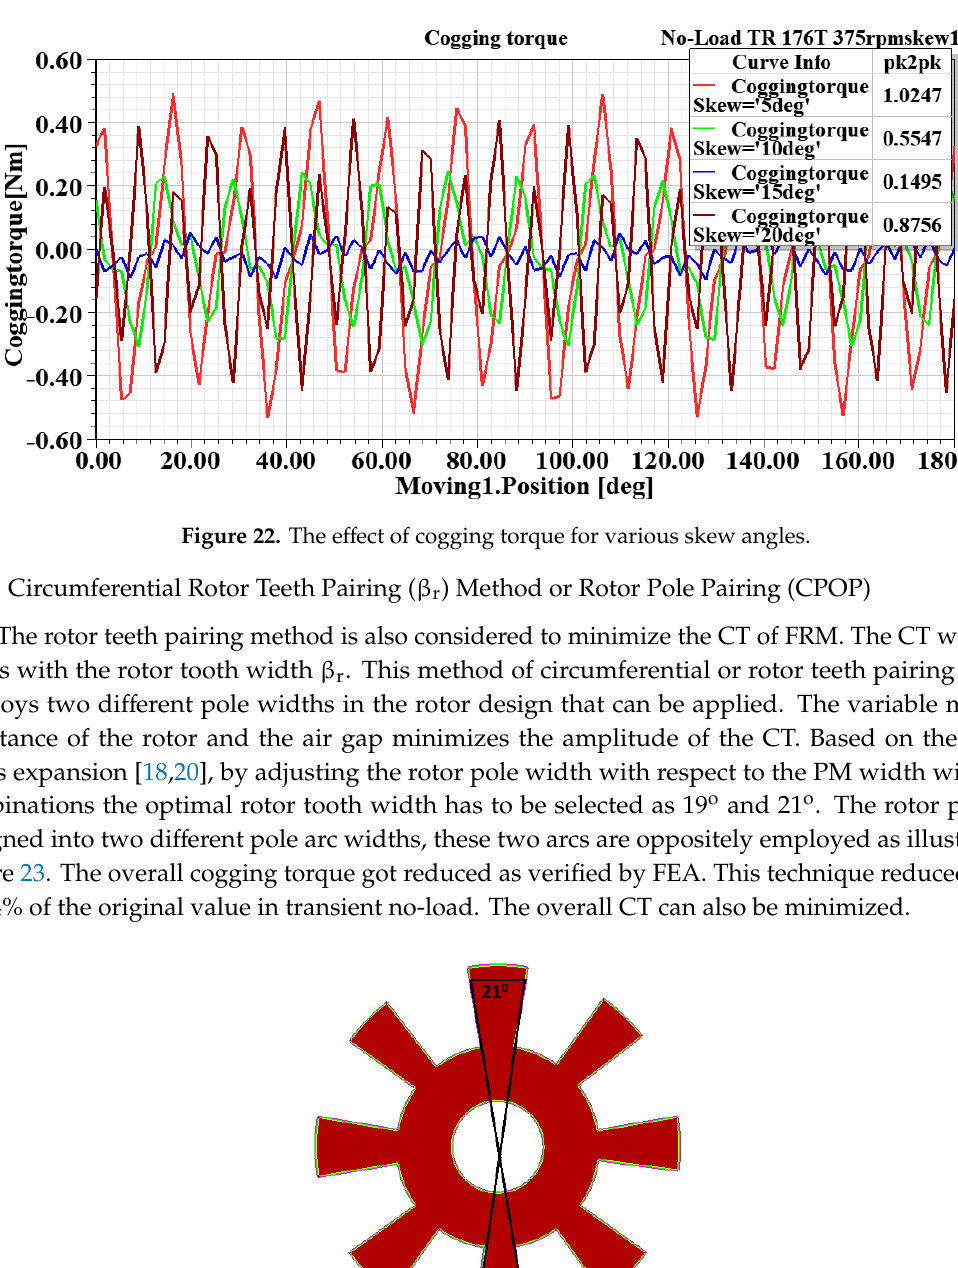
Figure 23. Cross-section of teeth paired rotor.